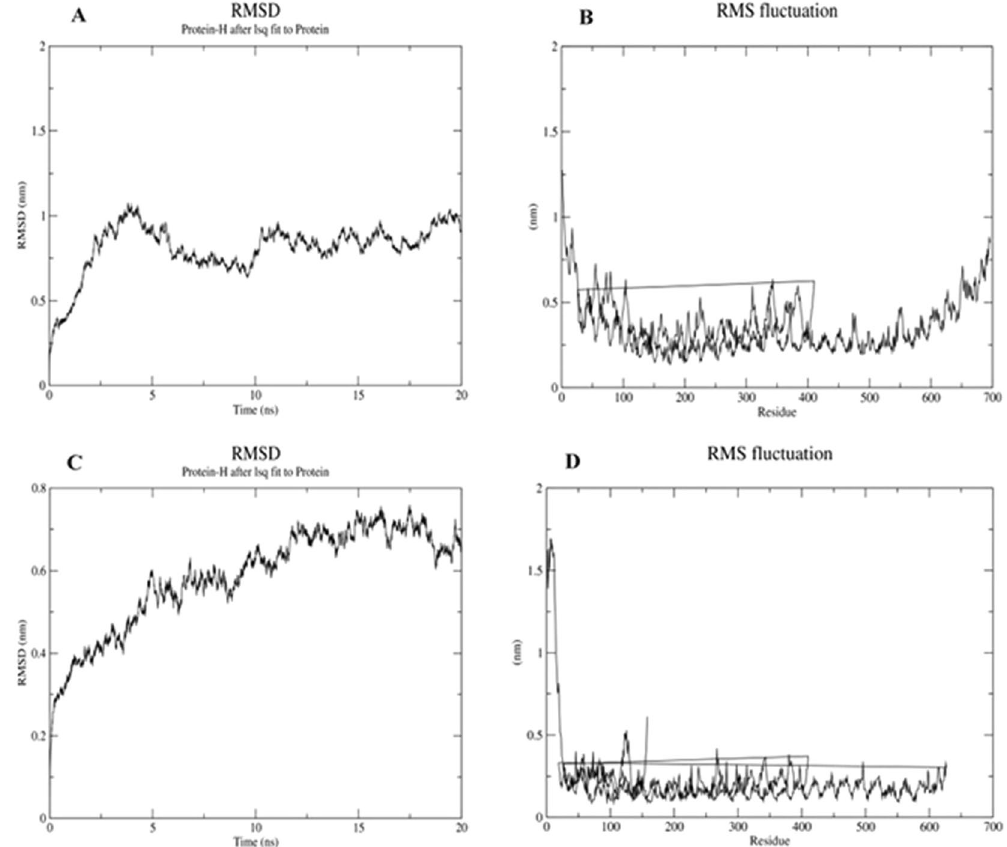
Figure 6. Molecular dynamics simulation study of Protein – protein complex for the timeduration of 20 ns. ( A ) RMSD of docked complex hemolin with TLR -3, ( B ). RMSF docked complex hemolin with TLR -3, ( C ). RMSD of hemolin and TLR- 4 MD2 docked complex, ( D ) RMSF of hemolin and TLR- 4 MD2 docked